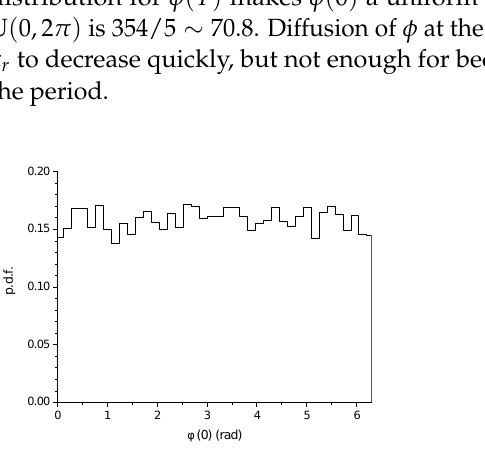
Figure 5. Probability density function of the initial value of the phase for T = 1 ns.